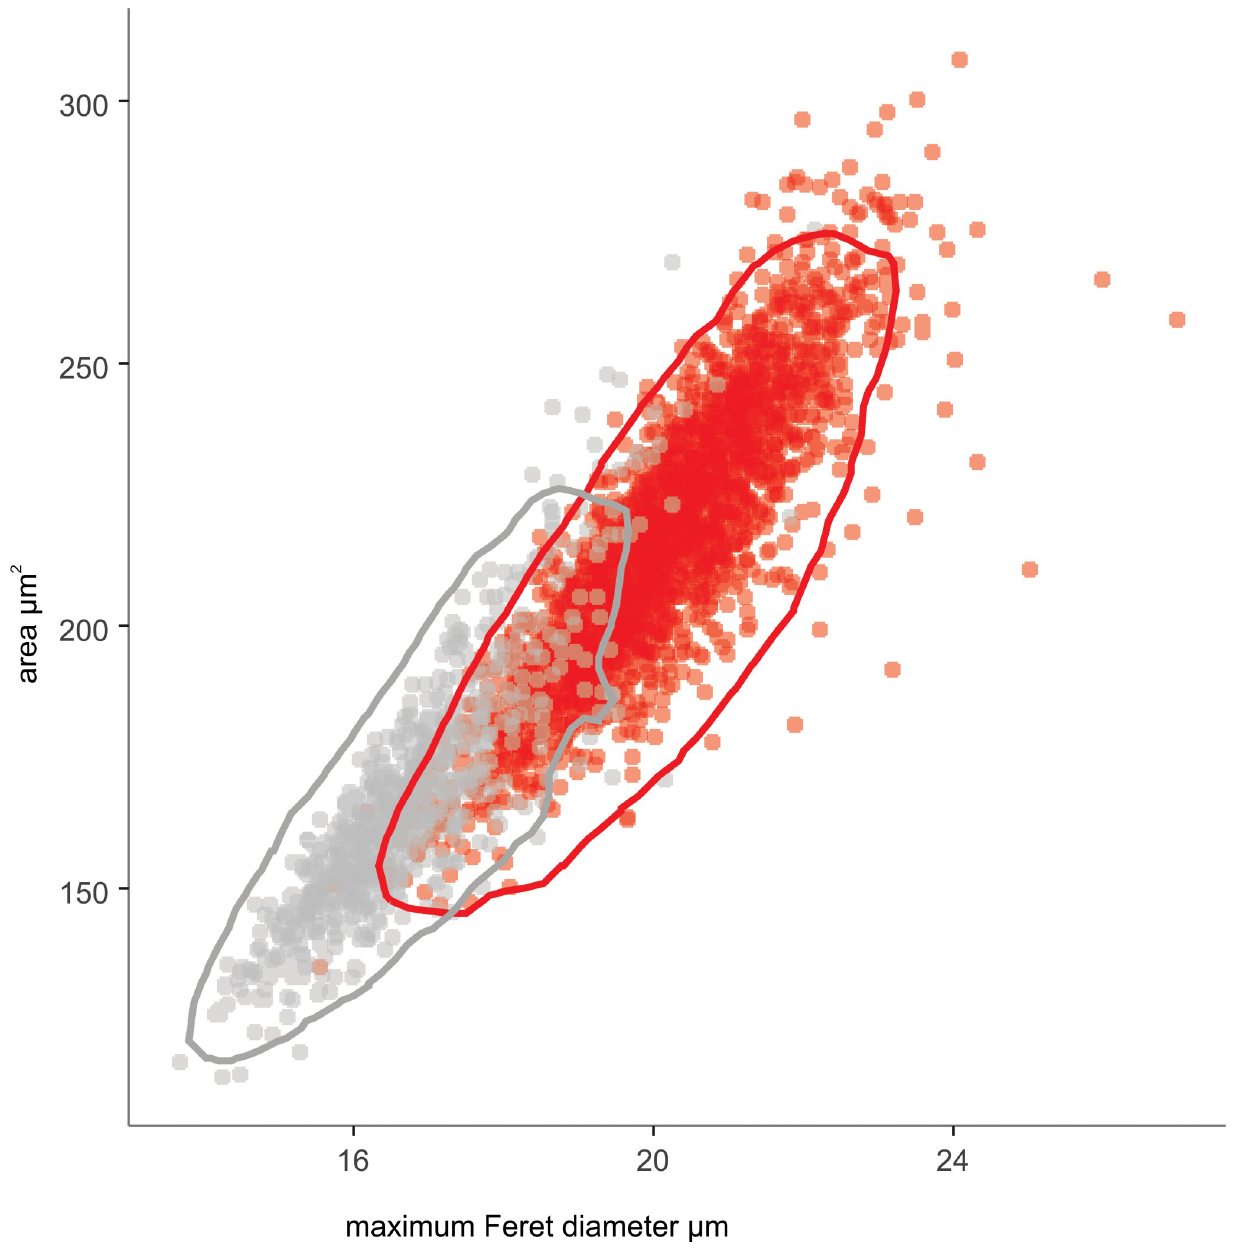
Fig 8. Classifynder measurements of area vs maximum Feret diameter of pollen in polar view. Leptospermum scoparium (red, n = 11932 specimens) and Kunzea (grey, n = 3678). Polygons show the 95% range of the highest posterior density region for each species, calculated using R package coda [44].